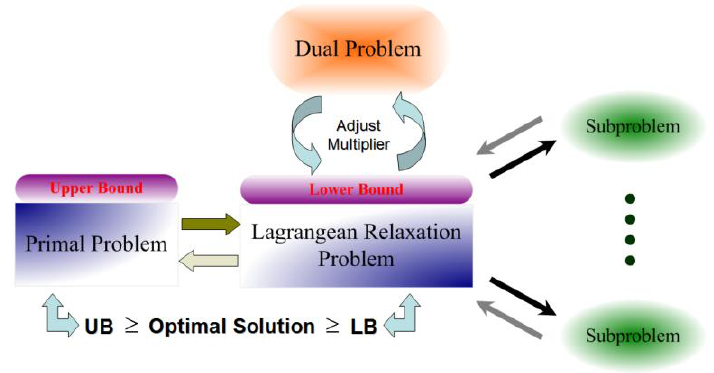
Figure 2. Concept of Lagrangian Relaxation Method.